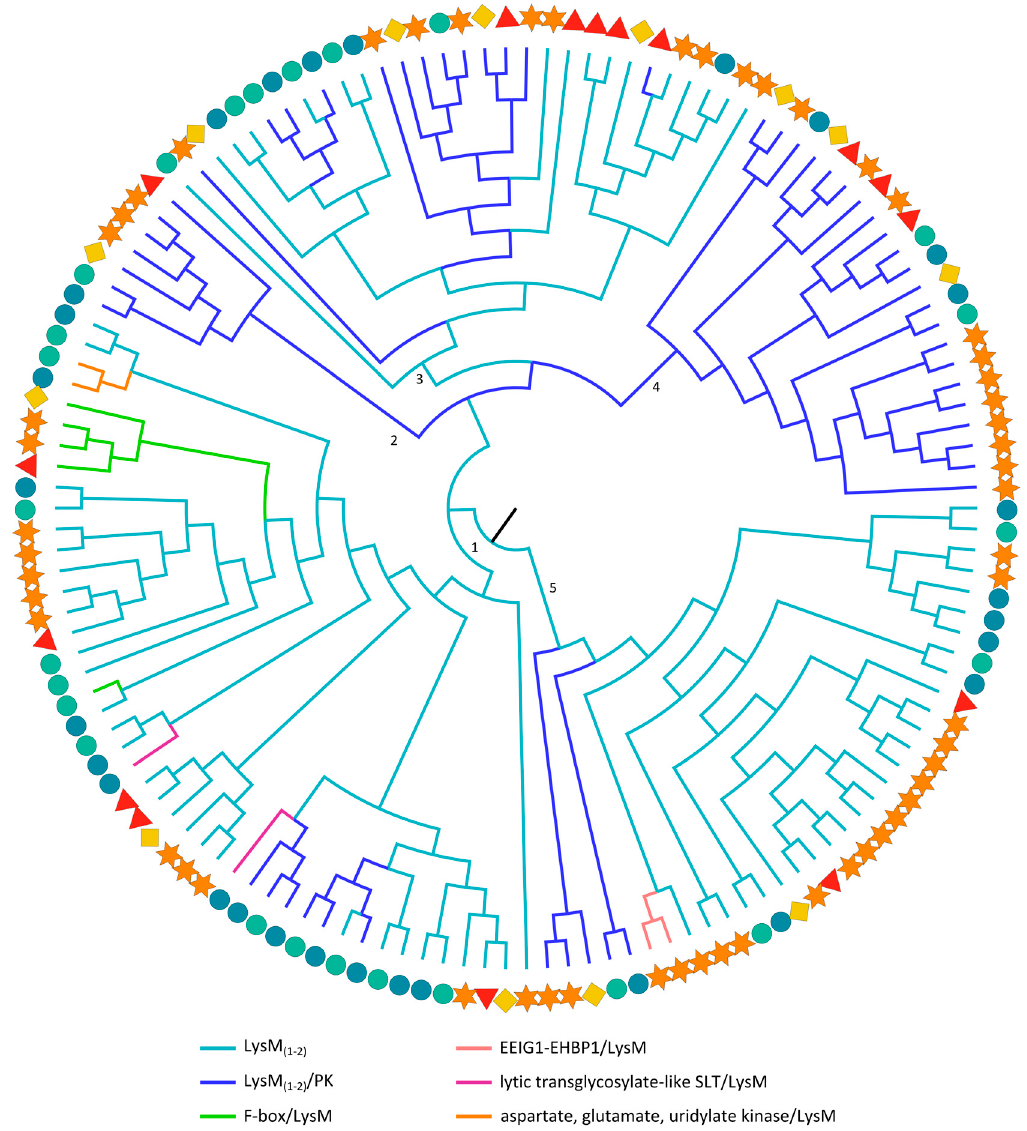
Figure 6. Evolutionary relationships of LysM sequences from Arabidopsis (red triangle), soybean (orange star), cucumber (yellow rhomb) and rice ( japonica : green circle, indica : blue circle). The colored branches of the midpoint rooted maximum likelihood tree reflect different domain architectures of the full-length sequences.